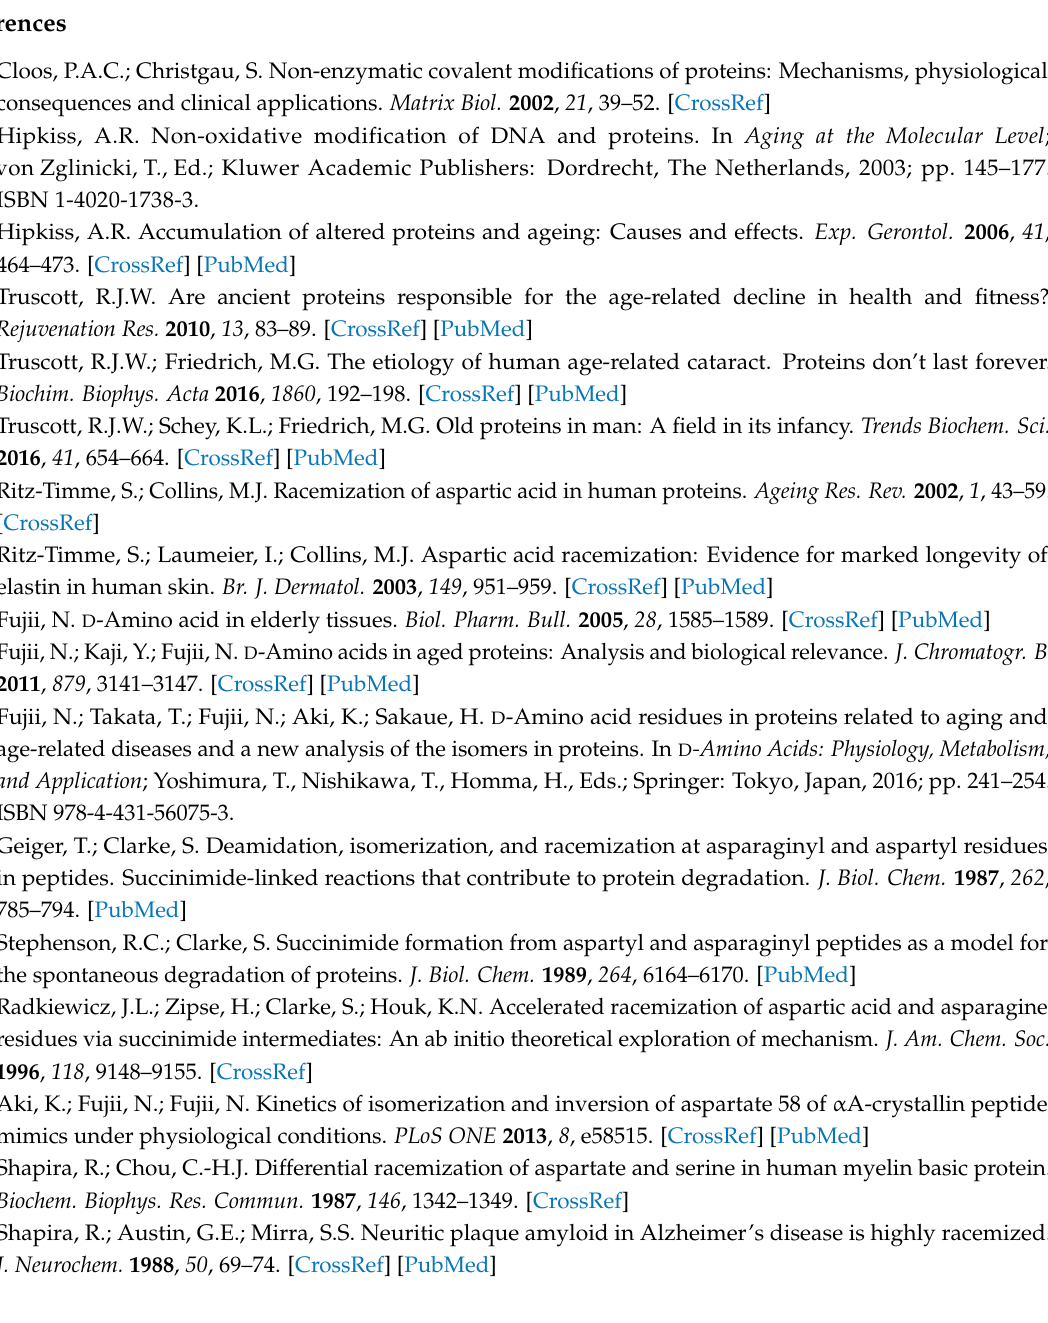
Supplementary Materials: The following are available online at www.mdpi.com/2073-4344/7/12/363/s1, Table S1: Total energies (au), zero-point energies (kJ mol − 1 ), and SM8 hydration Gibbs energies (kJ mol − 1 ) of the B3LYP/6-31+G(d,p) optimized geometries, Table S2: Cartesian coordinates (Å) of RC1, Table S3: Cartesian Table S6: Cartesian coordinates (Å) of TS2, Table S7: Cartesian coordinates (Å) of PC2, Table S8: Cartesian coordinates (Å) of RC3, Table S9: Cartesian coordinates (Å) of TS3, Table S10: Cartesian coordinates (Å) of